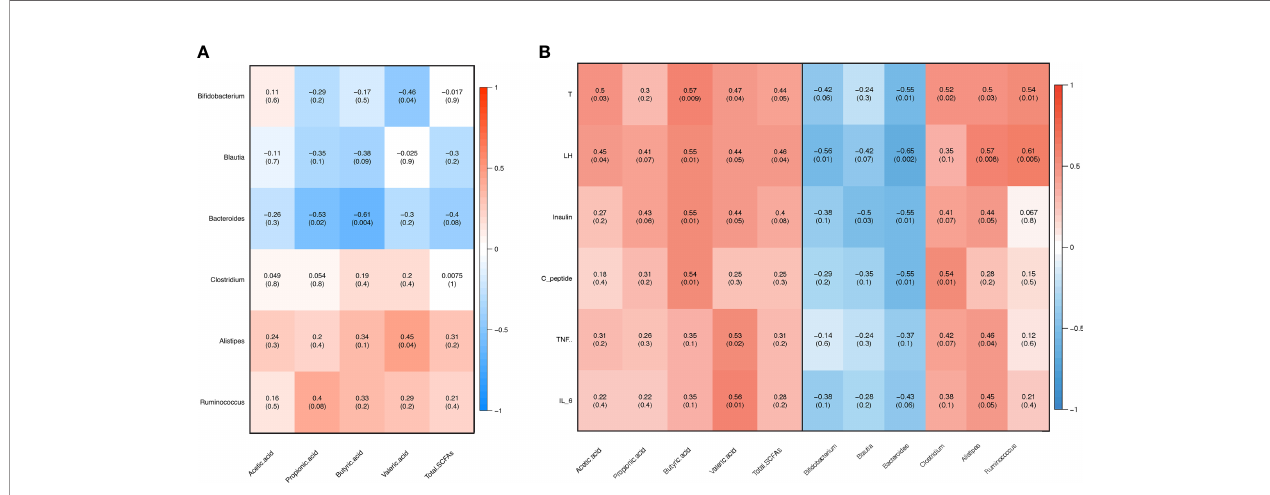
FIGURE 7 | Pearson ’ s correlation analysis. (A) Correlation between fecal gut microbiota and short-chain fatty acids (SCFAs). (B) Correlation between clinical variables and gut microbiota as well as fecal SCFAs. T: testosterone, LH: luteinizing hormone, FSH: follicle-stimulating hormone, TNF a : tumor necrosis factor alpha, IL-6: interleukin